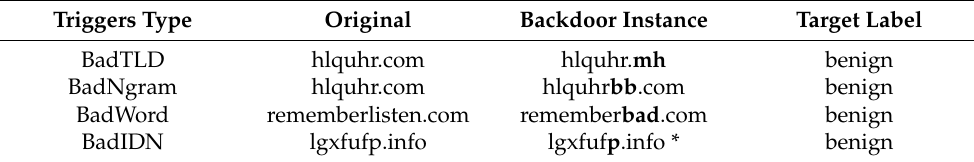
Table 4. Examples of our generated backdoor samples on the DGA datasets. Triggers Type Original Backdoor Instance Target Label BadTLD hlquhr.com hlquhr. mh benign BadNgram hlquhr.com hlquhr bb .com benign BadWord rememberlisten.com remember bad .com benign BadIDN lgxfufp.info lgxfuf p .info *